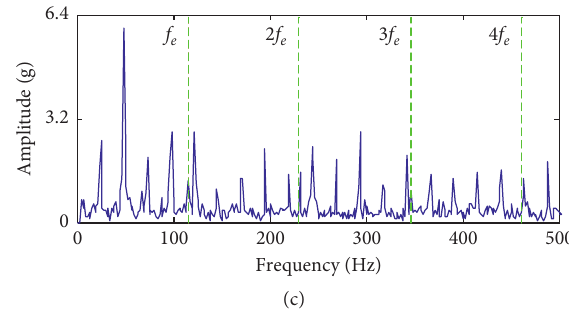
Figure 11: The collected experimental signal: (a) the waveform; (b) the frequency spectrum; (c) the envelope spectrum.